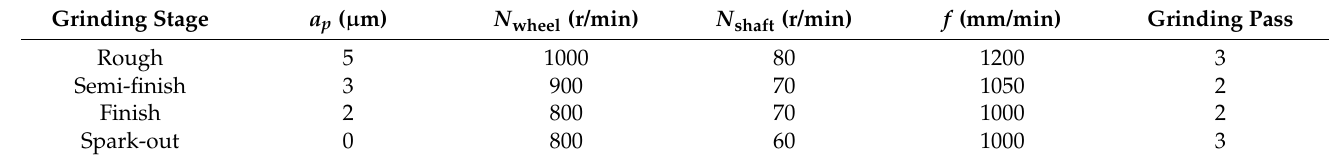
Table 4. The parameters of grinding